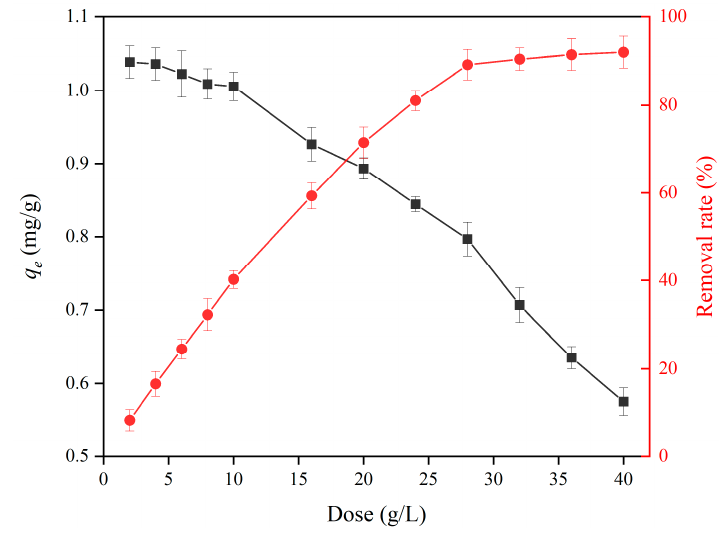
Figure 7. The effect of dosage on the adsorption capacity of bio-ceramsite.